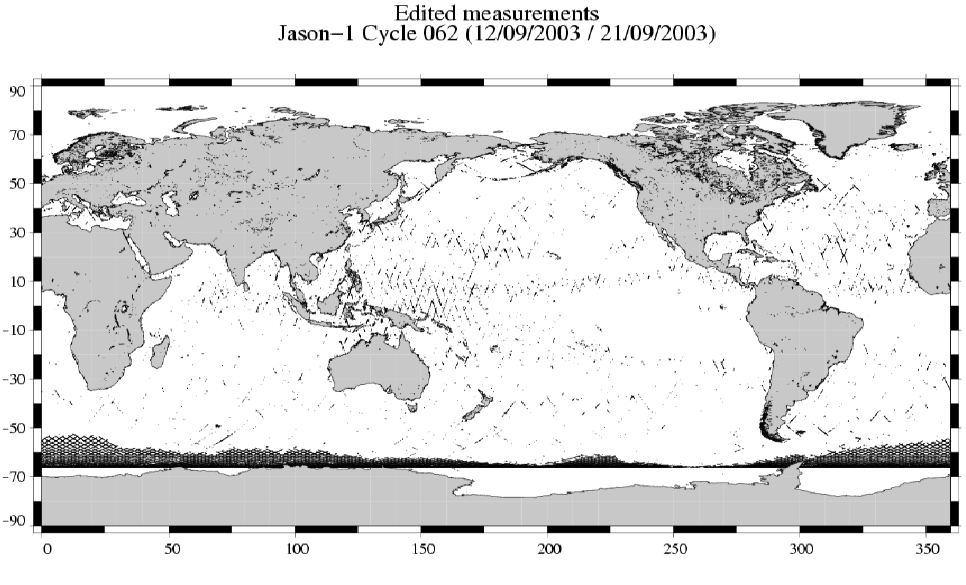
Figure 2. Edited measurements on Jason-1 cycle 062, for ocean